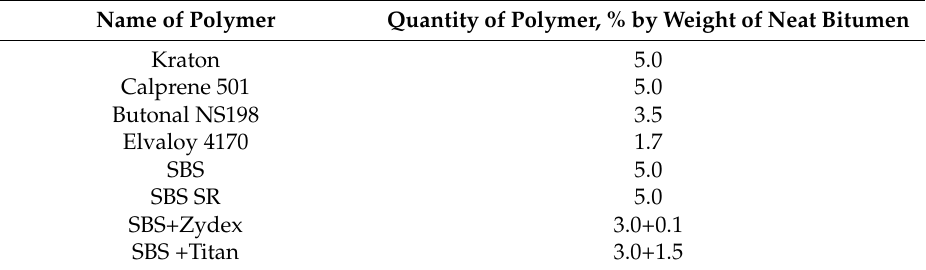
Table 2. Quantity of the polymers added to the bitumen of grade 130/200.